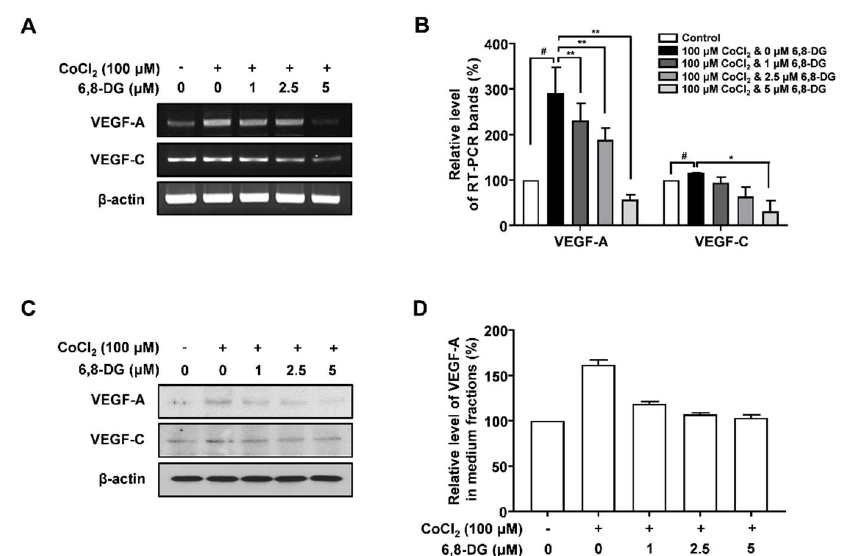
Figure 4. Effects of 6,8-DG on the expression of VEGF-A and VEGF-C in SCCVII cells treated with CoCl 2 . ( A ) cDNAs were generated from total RNAs treated with DNase I, and PCR reaction was performed with specific primers of VEGF-A and -C and β-actin. ( B ) PCR products from three independent experiments ( A ) were quantified and represented as a bar diagram. The levels of the VEGF-A and -C transcripts in the control (6,8-DG- and CoCl 2 -untreated cells) were estimated as 100%. ( C ) The protein levels of VEGF-A and -C in the intracellular fraction were determined using Western blot with anti-VEGF-A and anti-VEGF-C antibodies. ( D ) The protein level of VEGF-A in medium fractions was determined using ELISA assay. Data are presented as a mean ± S.D. of three independent experiments ( # p < 0.01, * p < 0.05, ** p < 0.01).